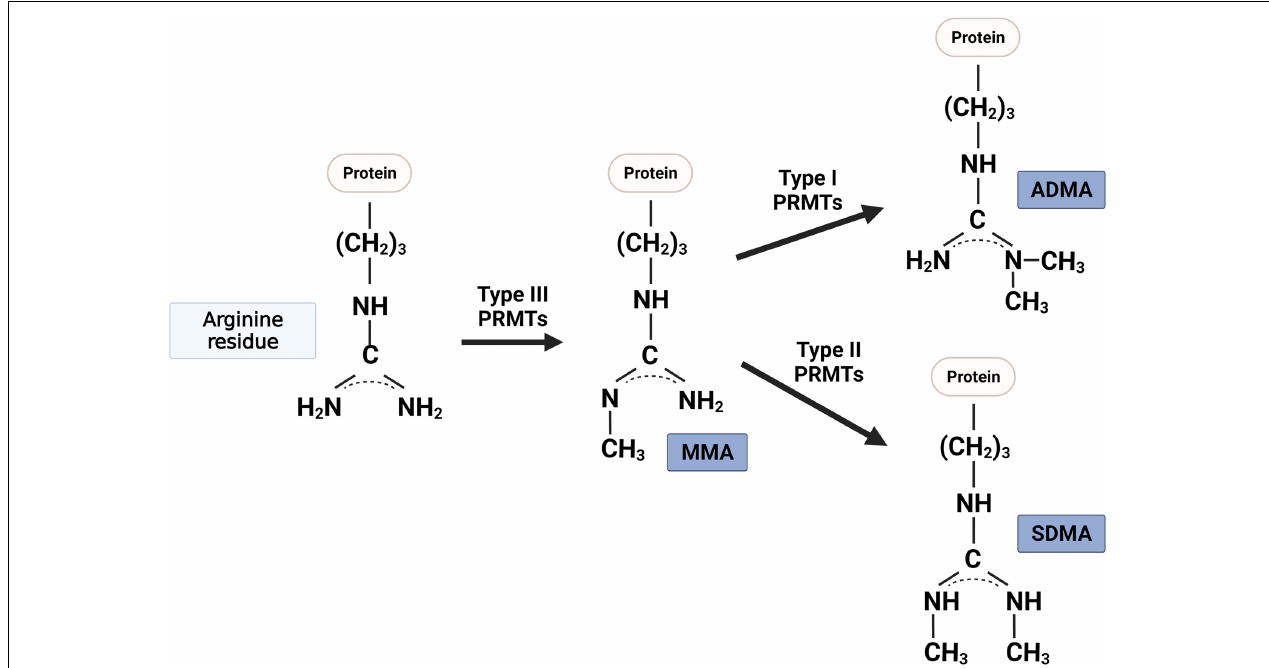
FIGURE 1 | Protein arginine methyltransferases (PRMT) that methylate the nitrogen of specific arginine residues in proteins are classified into three types: (i) type I PRMTs (i.e., PRMT1, PRMT2, PRMT3, PRMT4, PRMT6, and PRMT8) catalyze the asymmetric NG, NG-dimethylarginine (ADMA); (ii) type II PRMTs (i.e., PRMT5 and PRMT9) catalyze the symmetric NG, NNG-dimethylarginine (ADMA); and (iii) type III PRMT (i.e., PRMT7) generates one methyl group to one side of nitrogen of arginine residue